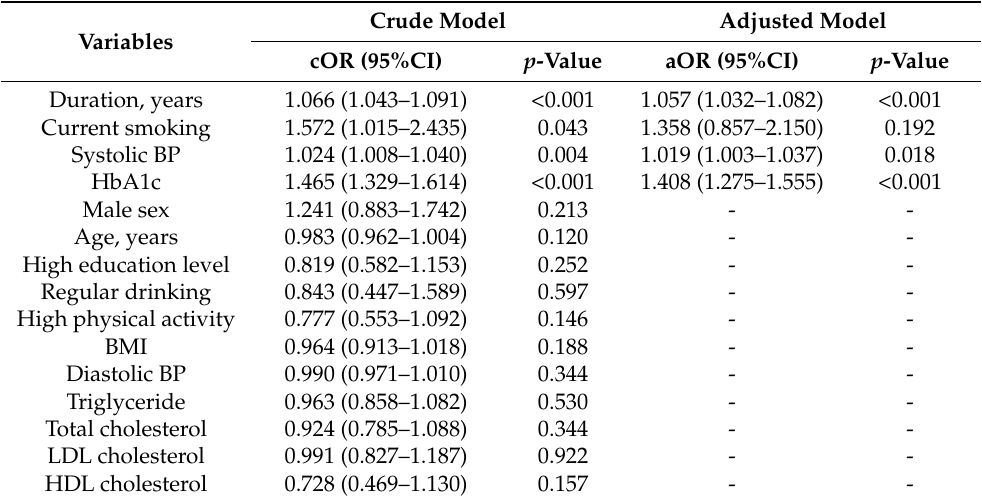
Table 4. Risk factors associated with diabetic retinopathy in normotensive patients with